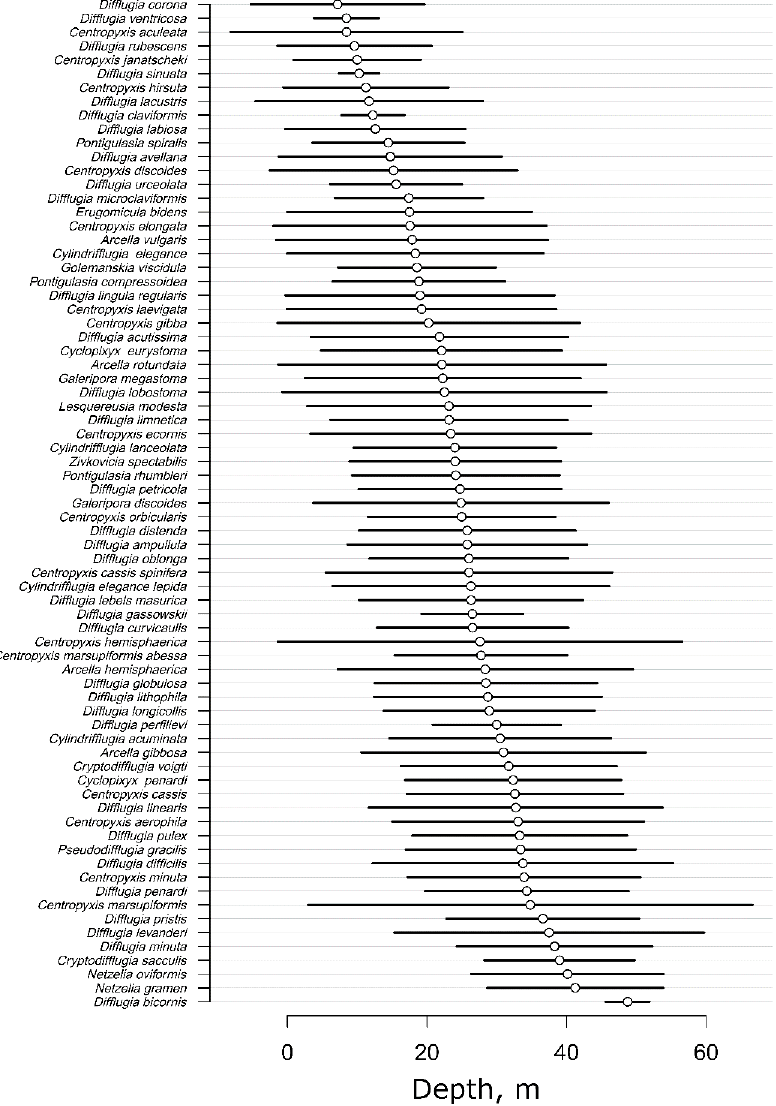
Figure 10. The depth optima and tolerance range of testate amoebae (only taxa encountered in three or more samples are